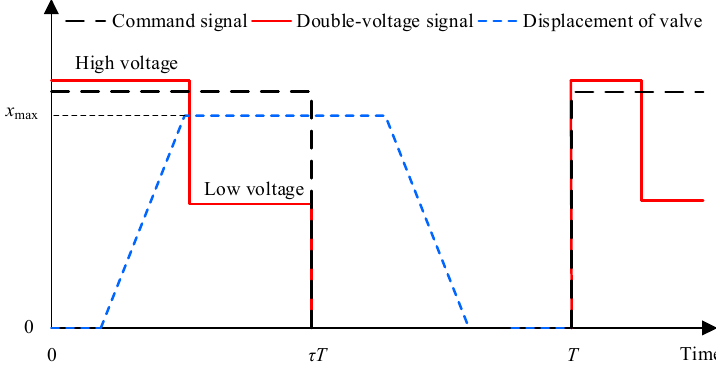
Figure 5. Diagram of double-voltage control signal.